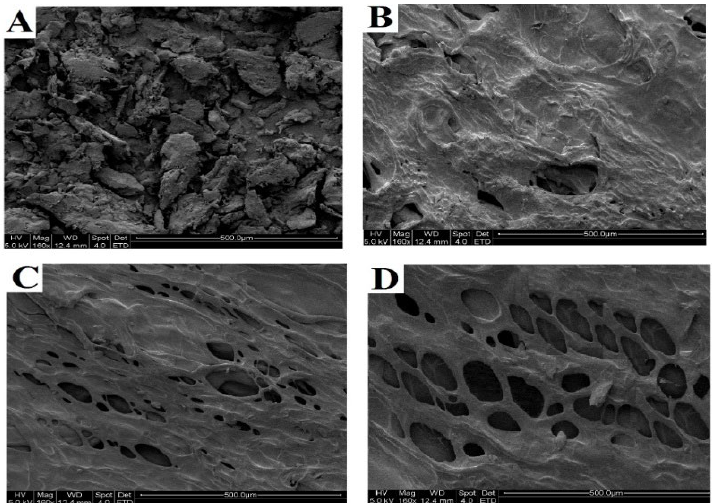
Figure 4. SEM of ( A ) Ca-alginate and IEs produced with ( B ) US, ( C ) MS, and ( D ) UMS treatments, at 160× magnification.